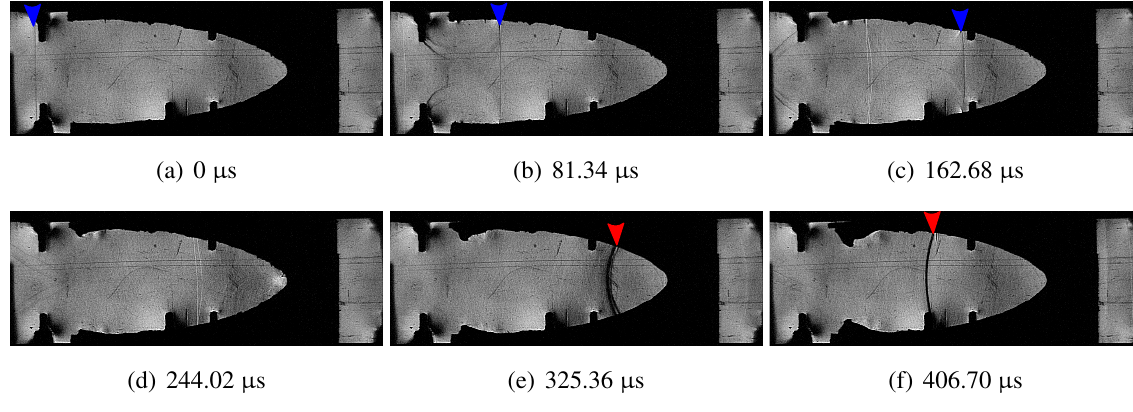
Figure 10. Open cell foam, Case 1C.